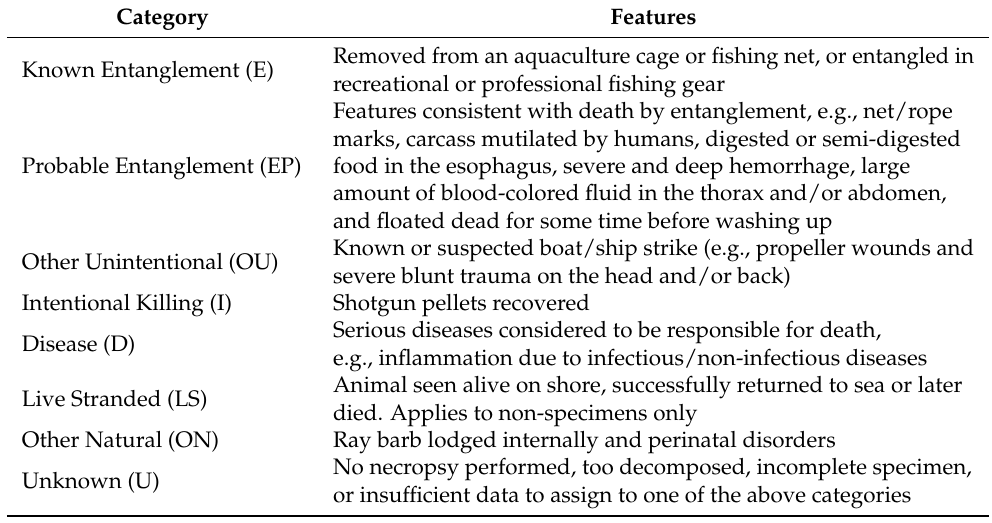
Table A2. Categories of the circumstances of death used in this study. Example features apply to this study. In the case of multiple features, several, but not necessarily all, were recorded in a particular case. See the Materials and Methods for a justification of categories and which apply to specimen and non-specimen records.